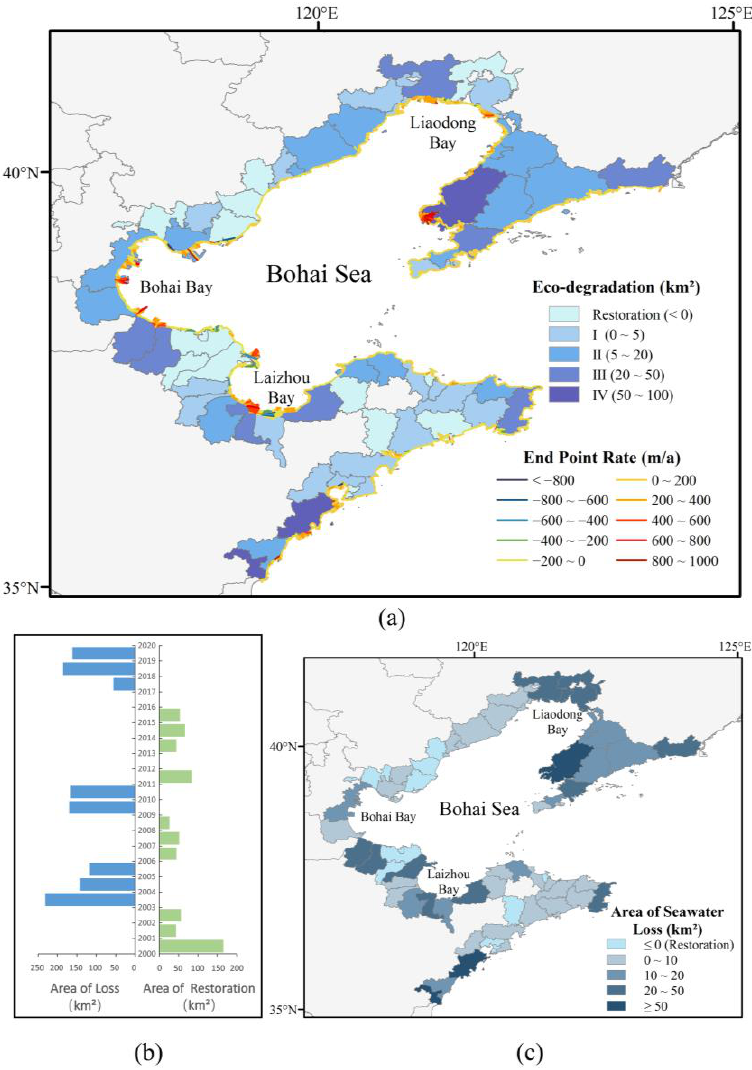
Figure 7. Ecological effects of coastline changes in the Bohai Sea coastal zone (2000–2020): ( a ) coupling of coastline migration rate and ecological land loss; ( b ) changes in total ecological losses; ( c ) loss of seawater ecological land.